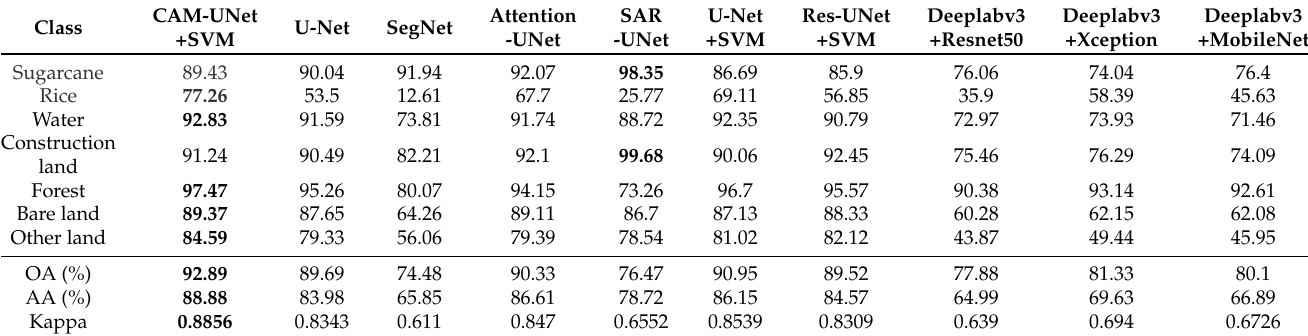
Table 6. Comparison of the classification accuracy of different methods for the validation set of remote sensing images in the study area